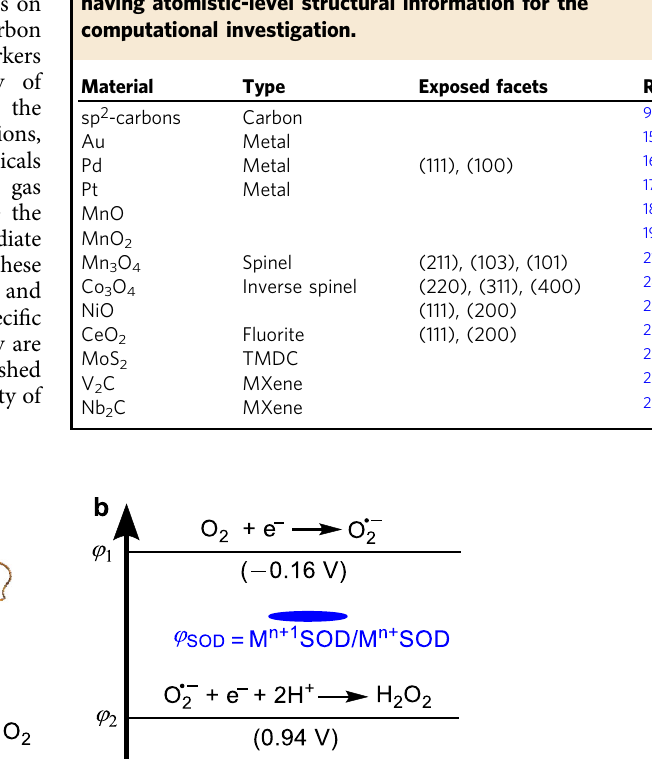
Fig. 1 Metalloenzyme catalytically scavenging O 2 (cid:129) − . a The superoxide dismutase (SOD) that scavenges O 2 (cid:129) − by catalyzing its dismutation reaction. b The reduction potential model predicting the catalytic activity of SOD. In b , φ 1 and φ 2 are the reduction potentials of O 2 /O 2 − and O 2 − , H + /H 2 O 2 , respectively, and their values at pH = 7 are given in the parentheses.